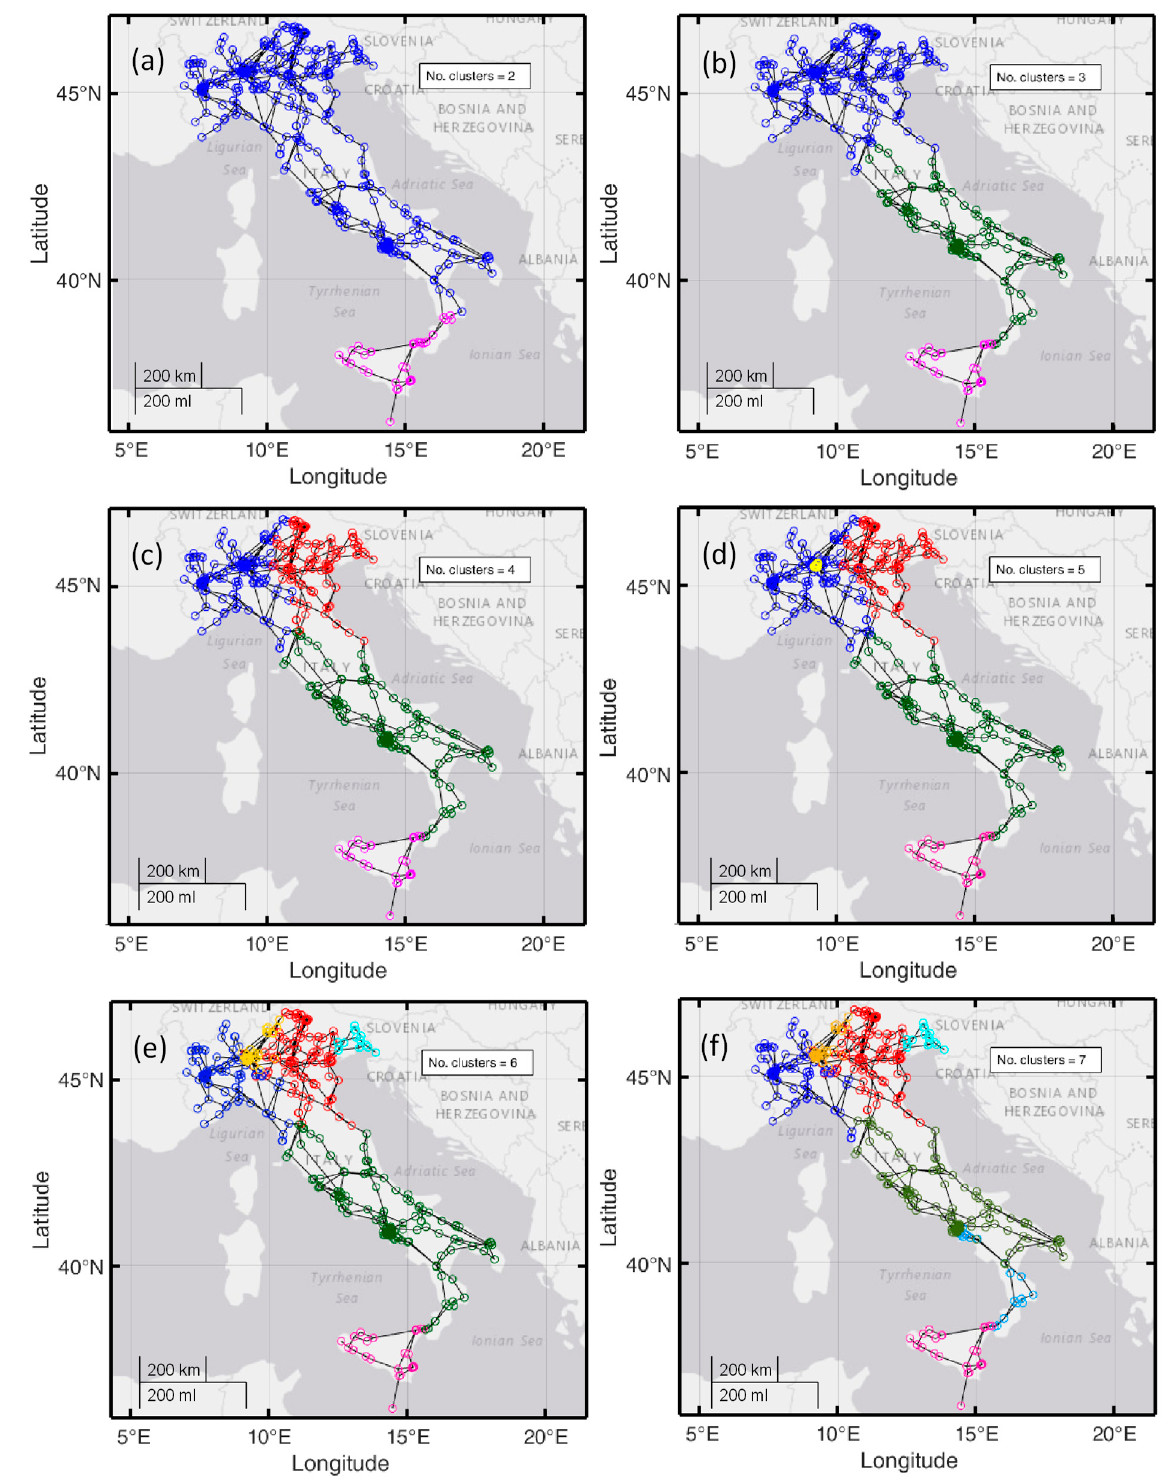
Figure 9. Results for different number of clusters. The considered features are LMP s. The clustering algorithm adopted to group nodes within each scenario is HC-average. Subfigure ( a ) depicts the solution for 2 clusters, subfigure ( b ) for 3 clusters, subfigures ( c ) for 4 clusters, subfigures ( d ) for 5 clusters, subfigures ( e ) for 6 clusters, and subfigure ( f ) for 7